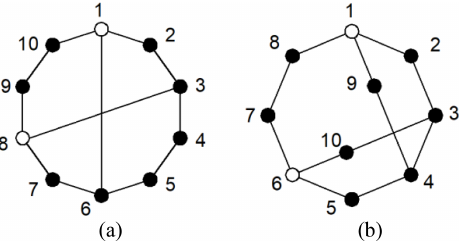
Figure 4. (a) An 8-link KC with two multiple joints (1) and an (b) 8-link KC with two multiple joints